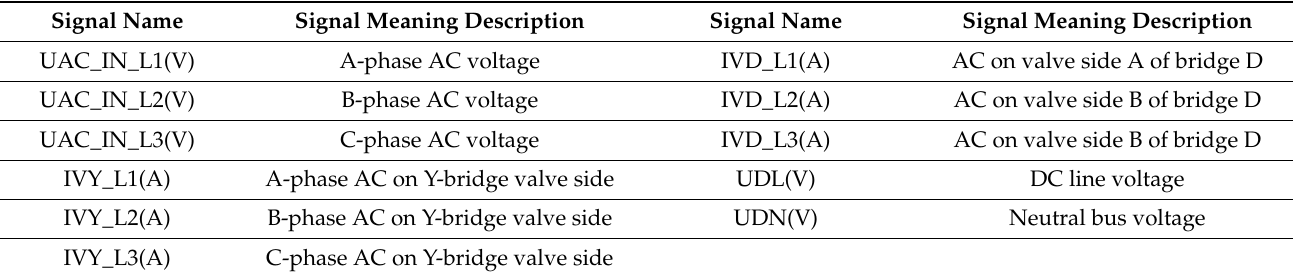
Figure 4. Main fault points of a substation in a southwest power grid in China. Table 2. Signal names and meaning descriptions.